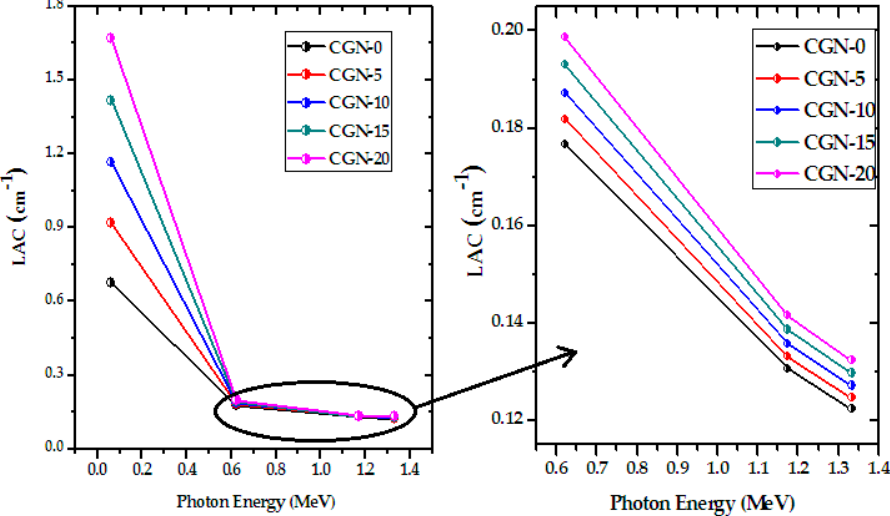
Figure 9. The LAC as a function of energy for different prepared CGN-mortar samples.